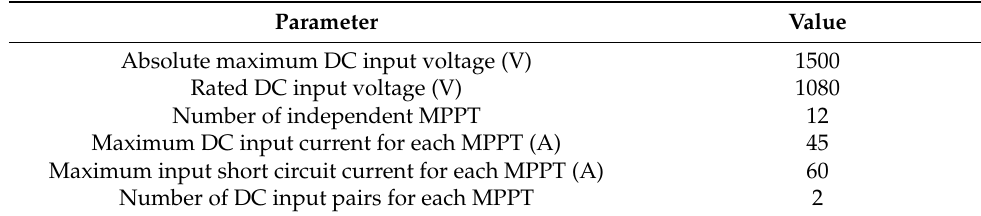
Table 2. Solar inverter’s DC input